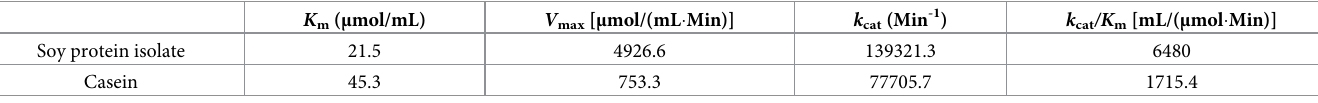
Table 3. Kinetic parameters of recombinant HypZn for casein and soy protein isolates. K m ( μ